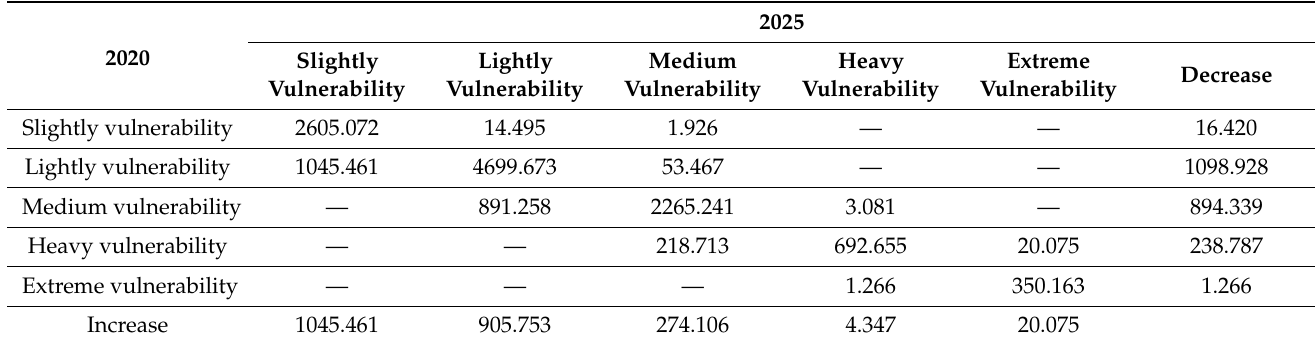
Table 8. Transfer of ecologically vulnerable areas in Shenyang in 2020 and 2025